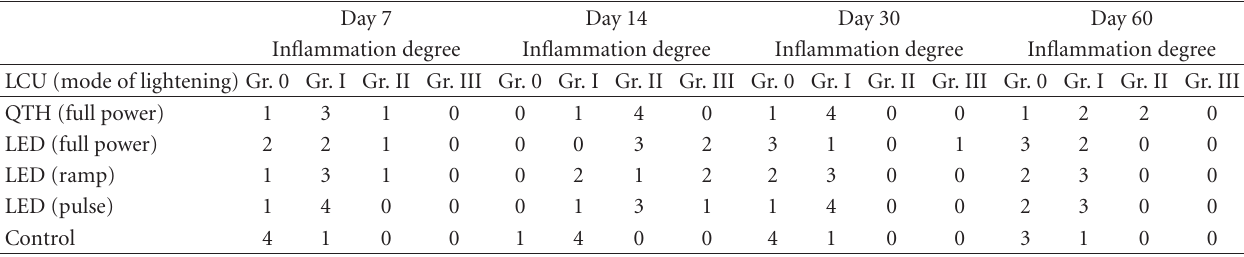
Table 4: Inflammation degree produced by light curing units in di ff erent modes of